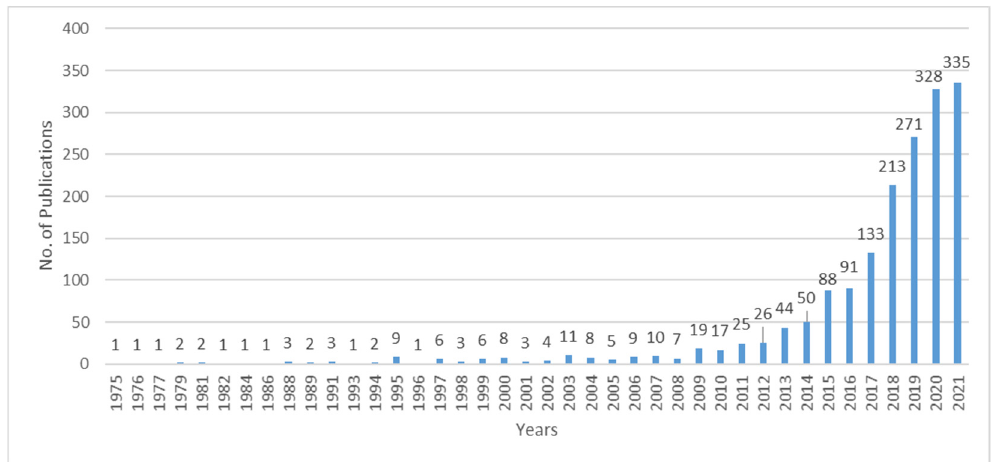
Figure 1. Time distribution of the number of published papers.